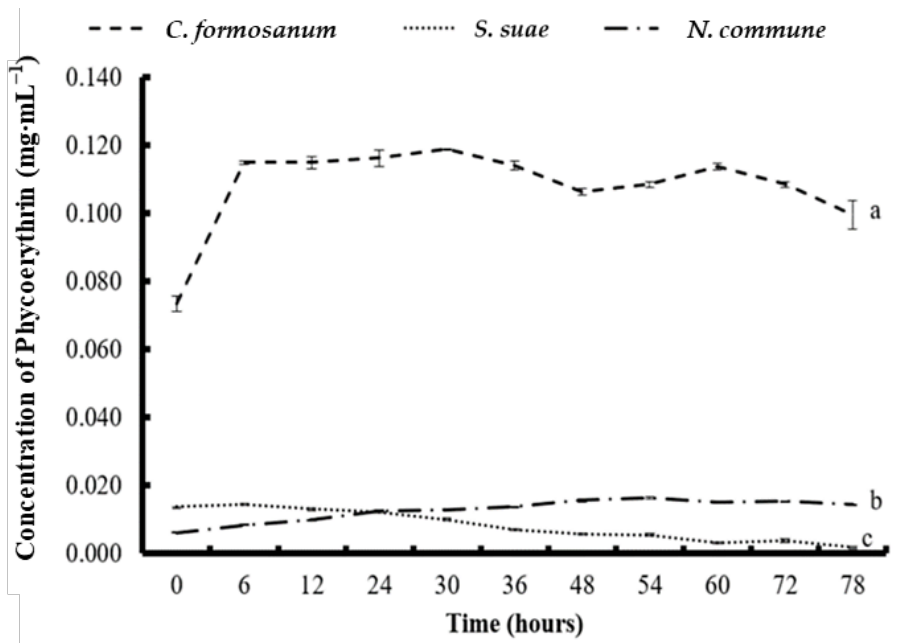
Figure 1. The concentration of phycoerythrin in (a) Colaconema formosanum , (b) Sarcodia suae , and (c) Nostoc commune as substrates fermented with Pseudoalteromonas haloplanktis , ATCC 14393. The APC concentration increased slightly between the start of fermentation and 36 h, and the highest APC concentration (0.096 mg mL − 1 ) was obtained at 36 h. After 36 h, the APC concentration decreased slightly (Figure 3). The Chl a concentration gradually rose until 72 h, when it reached its highest concentration (22.12 mg mL − 1 ; Figure 4). In the S. suae fermentation experiment, the highest PE and PC concentrations (0.014 and 0.026 mg mL − 1 ) were obtained at 6 h and 54 h, respectively. The APC concentration gradually increased from the beginning of the experiment until 72 h. The highest APC concentration was 0.027 mg mL − 1 at 72 h. Additionally, the Chl a concentration increased slightly and gradually, reaching its highest concentration of 4.93 mg mL − 1 at 72